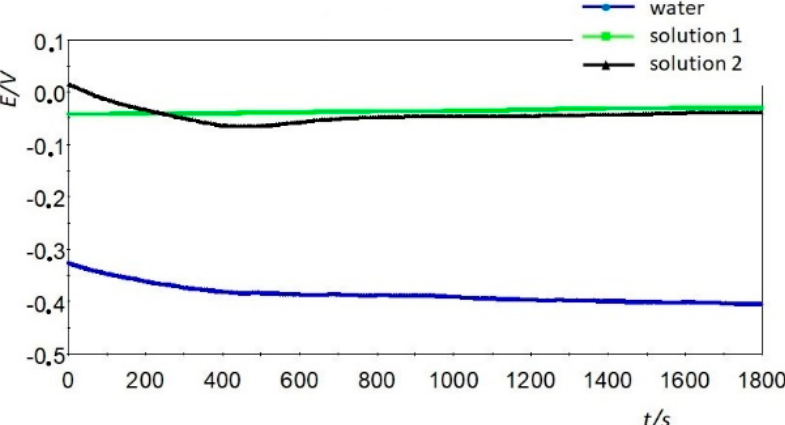
Figure 3. Time dependence of the open circuit potential of HTCS-130 tool steel in water, solution 1, and solution 2. and solution